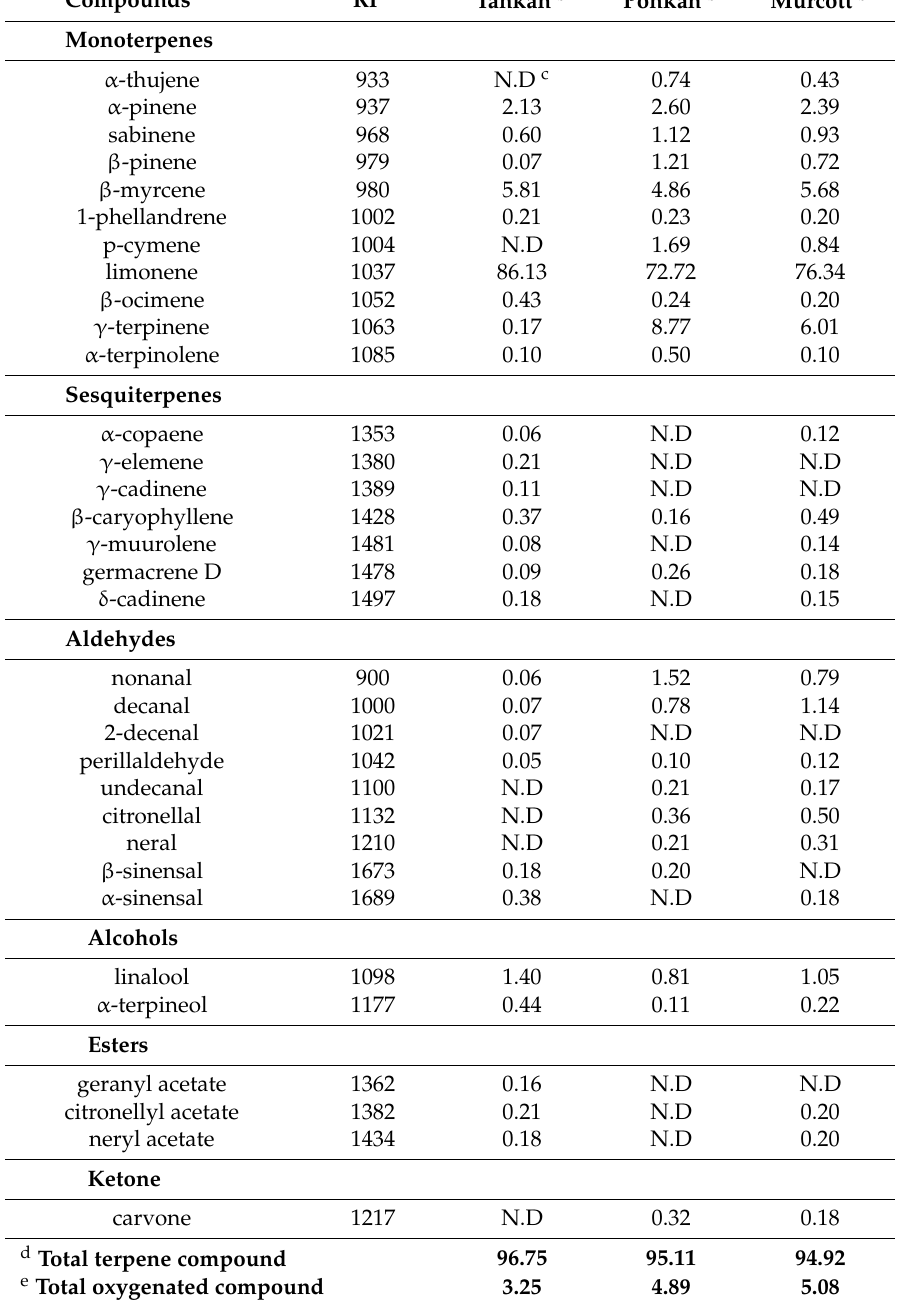
Table 1. Volatile constituents (%) of citrus